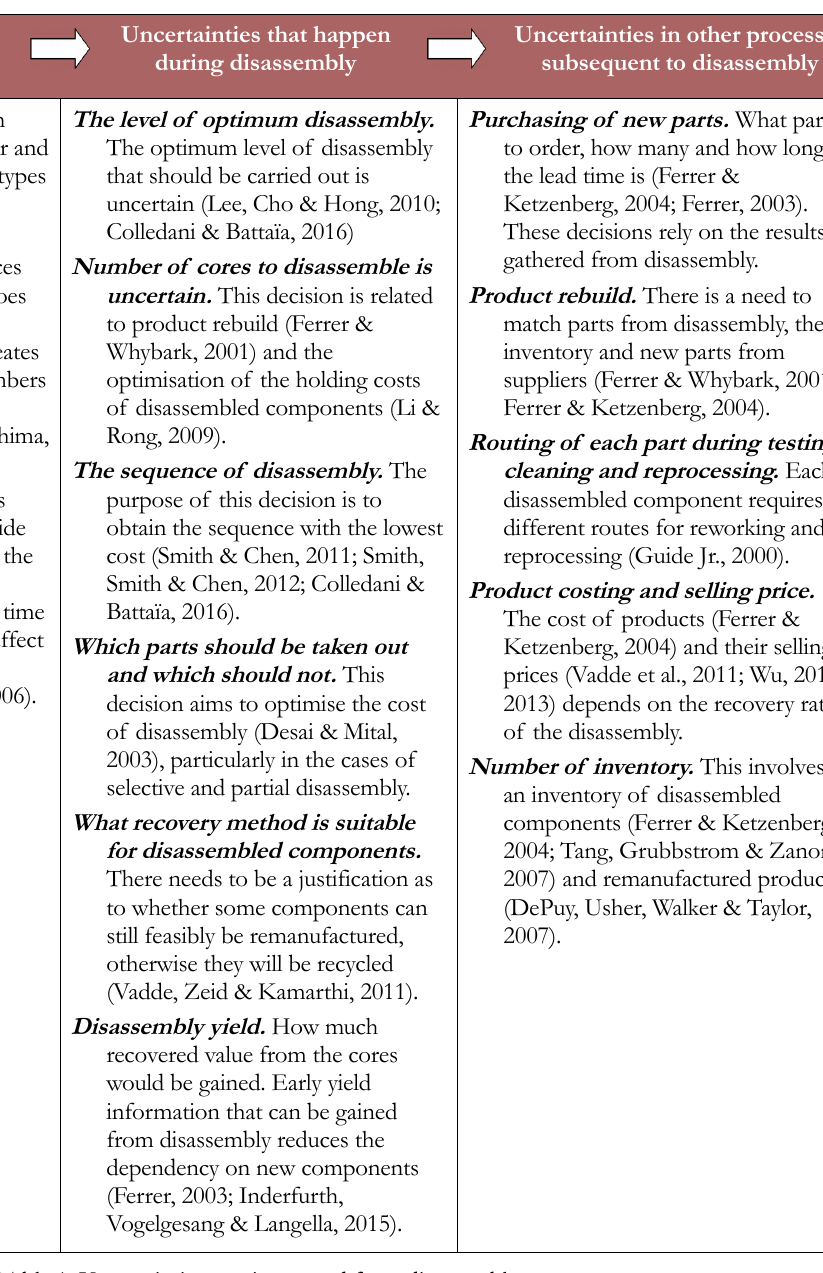
Table 1. Uncertainties coming to and from